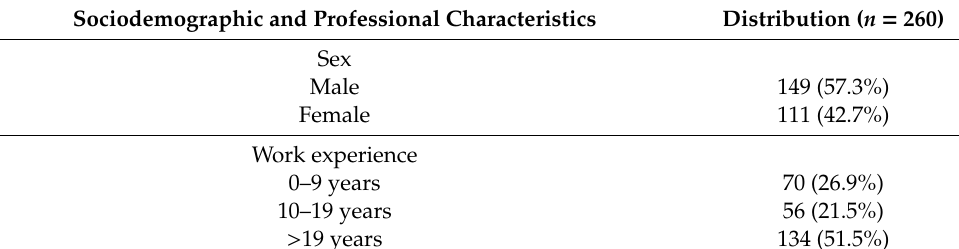
Table 1. Sociodemographic and professional data of the survey